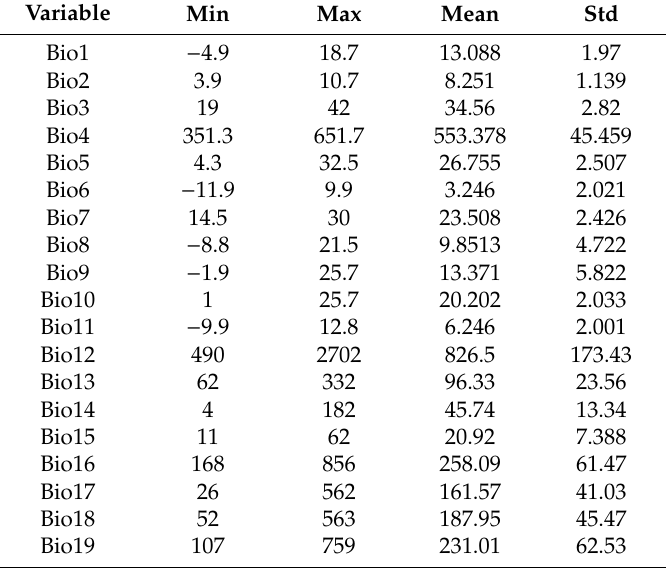
Table A3. 19 Bioclimatic variables of 2050 RCP6.0 scenario (see Figure 1 for variables names).